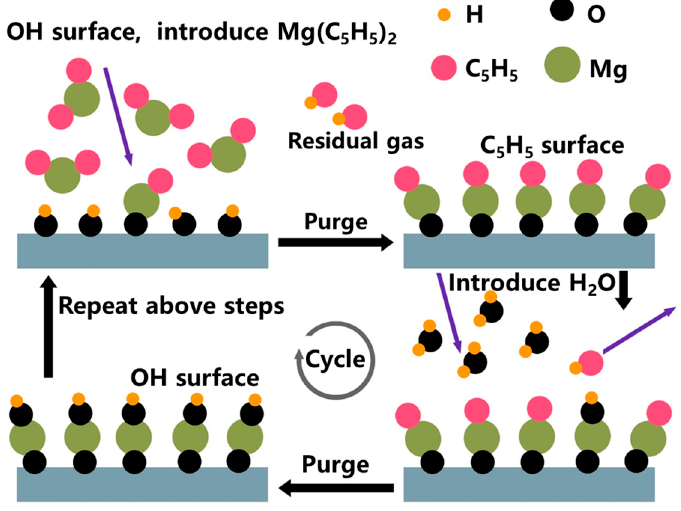
Figure 1. Sketch map of ALD processes for MgO coating